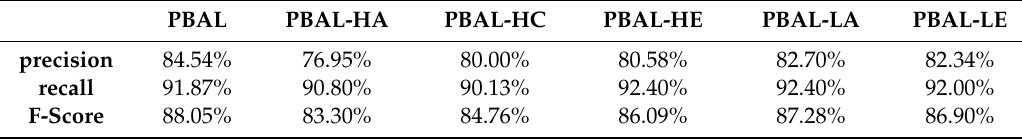
Table 10. Experimental results of the PBAL method lacking a set of personality in dataset